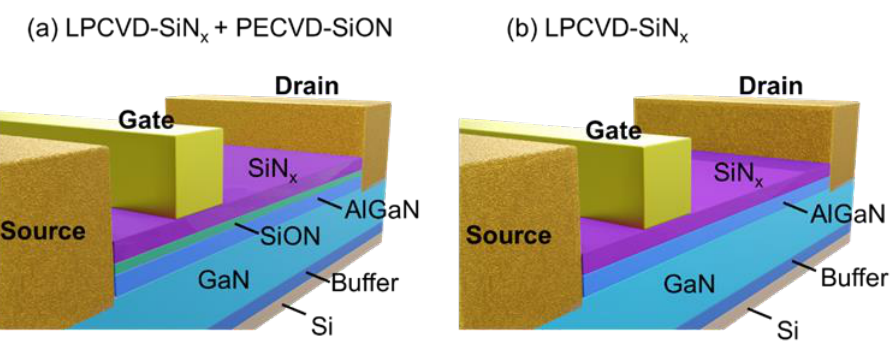
Figure 1. Schematics of MIS-HEMTs with ( a ) SiN x /SiON and ( b ) SiN x gate dielectric. The gate-to- source distance (L gs ), gate-to-drain distance (L gd ), gate length (L g ), and gate width (W g ) were 2 μm, 14 μm, 2 μm, and 100 μm, respectively .